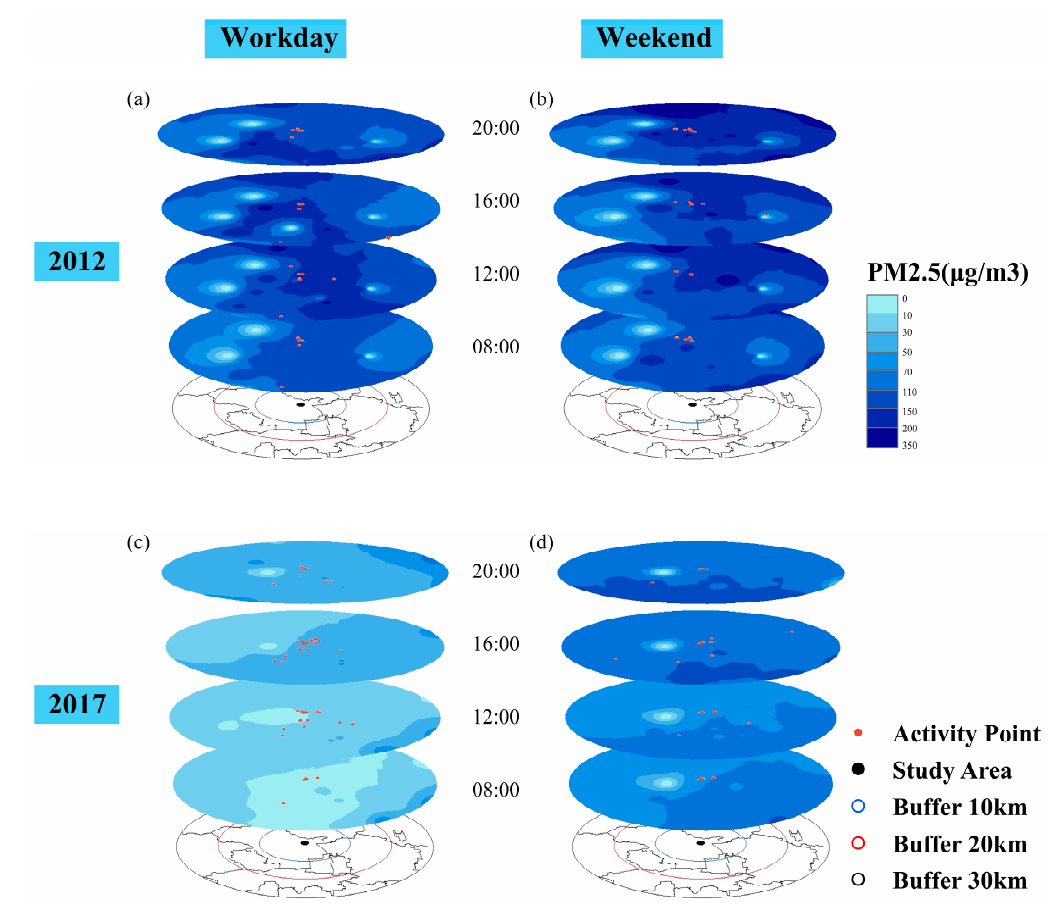
Figure 4. Real-time activity points and monitored air pollution at four times on ( a ) workdays in the 2012 dataset, ( b ) weekends in the 2012 dataset, ( c ) workdays in the 2017 dataset, and ( d ) weekends in the 2017 dataset.